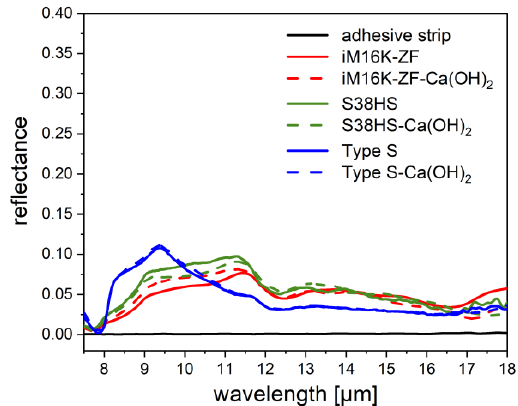
Figure 13. Reflectance behavior of the adhesive strip, the original spheres and the pre-conditioned spheres in the wavelength range of 1.6 to 25 µ m. Less or no influence of the adhesive strip and spheres in the wavelength range of 1.6 to 25 µm. Less or no influence of the adhesive strip and pre- conditioning in the wavelength range of interest (10 to 18 µm) is assumed. pre-conditioning in the wavelength range of interest (10 to 18 µ m) is